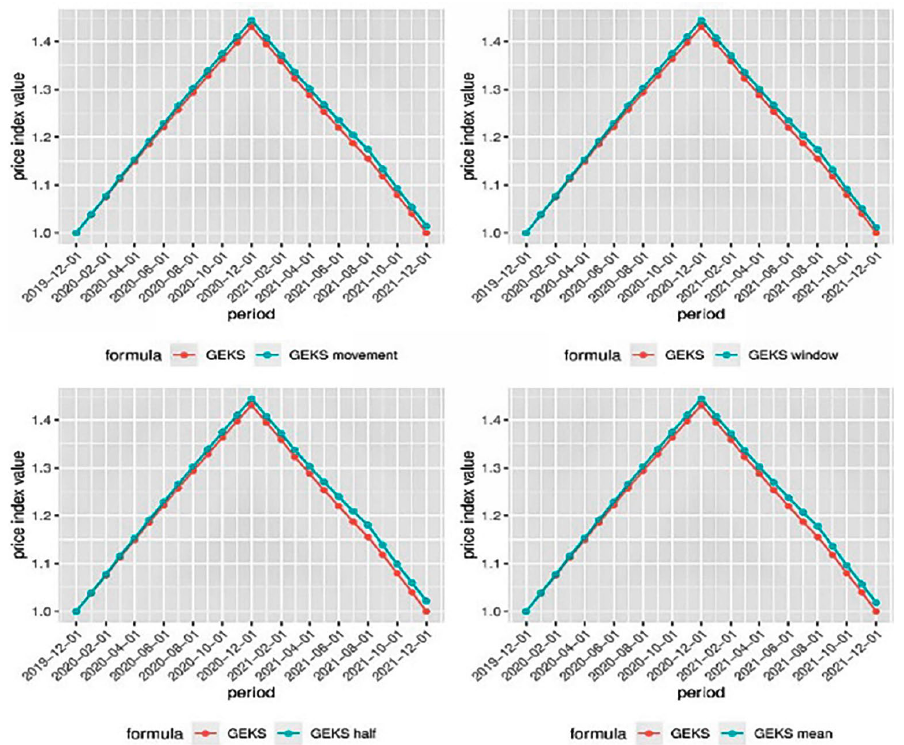
Figure 4. Comparison of selected splice GEKS indices to the full-window GEKS method for Case 1 and for d =